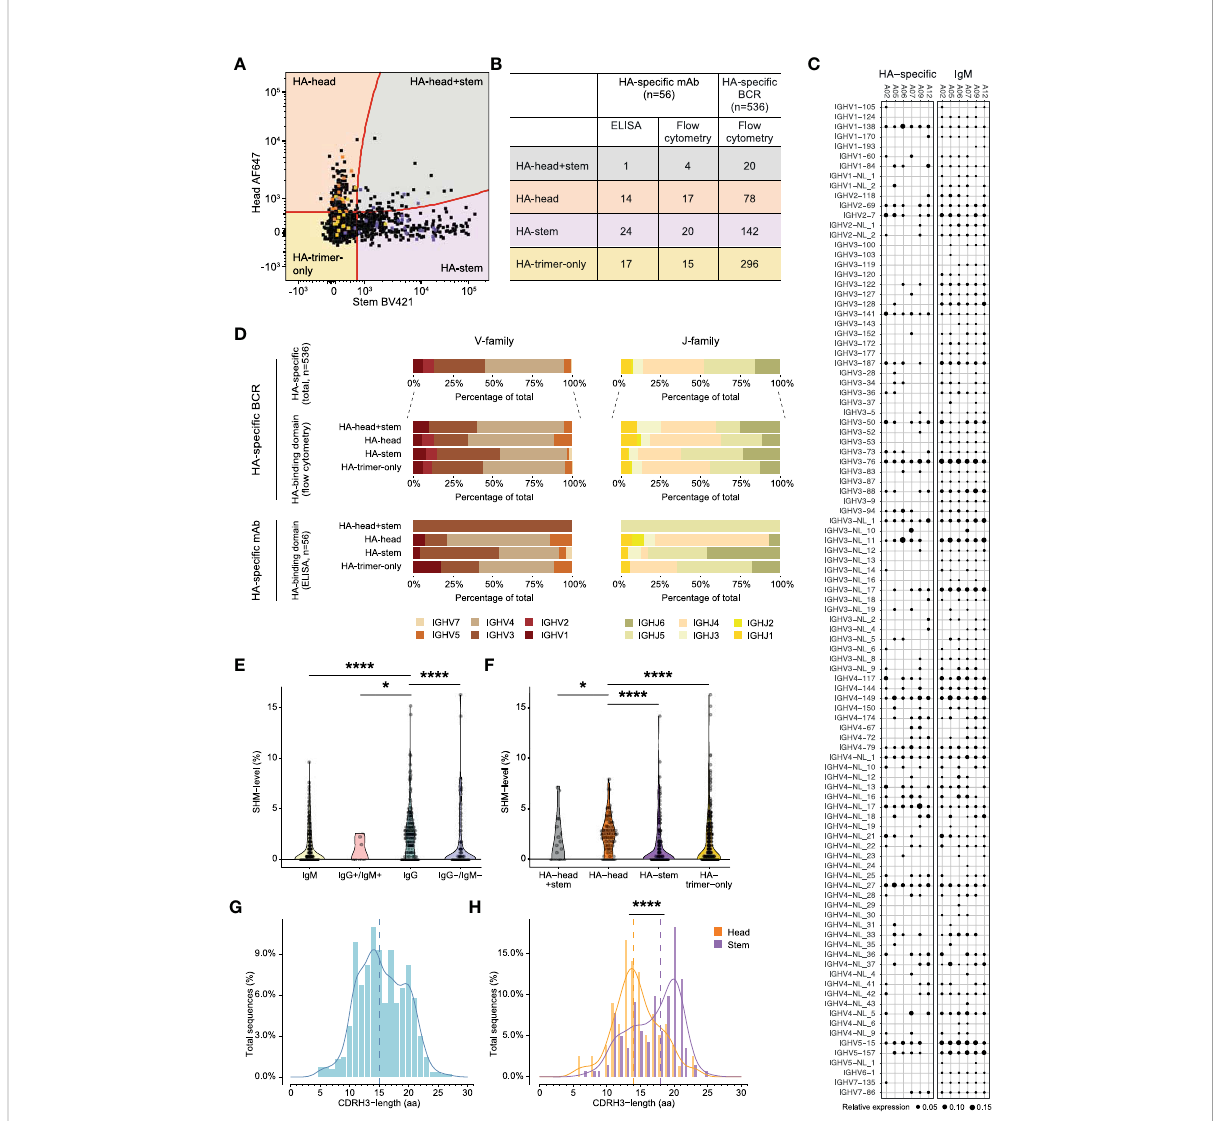
FIGURE 3 Characteristics of HA-speci fi c BCR repertoire and monoclonal antibodies (A) Overlay fl owcytometry plot of index-sorted HA-speci fi c B cells of six animals. Original B cells of isolated monoclonal antibodies are highlighted according to ELISA binding pattern, in orange HA-head, in yellow HA-trimer-only, in purple HA-stem, and in grey HA-head+stem. (B) Table presenting the binding domain of HA-speci fi c mAb in ELISA and fl ow cytometry and the binding domain HA-speci fi c BCRs in fl ow cytometry. (C) BCR repertoire of IgM germline and HA-speci fi c VH-gene usage. Size of the dots represent relative gene expression per animal. (D) Bar plots representing VH-gene (left) or JH-gene (right) family usage of HA- speci fi c total BCRs, HA-head+stem, HA-head, HA-stem, and HA-trimer-only speci fi c BCRs (upper panel) or isolated monoclonal antibodies (lower panel). (E) Violin plot showing VH-gene SHM-level of pre- (green) and post- infection HA-speci fi c BCRs. Post-infection BCRs are shown in IgM+, IgM+/IgG+, IgG+, and IgM-/IgG- isotypes. (F) Violin plot showing VH-gene SHM-level of HA-head+stem (grey), HA-head (orange), HA- stem (purple), and HA-trimer-only (blue) speci fi c BCRs. (G) Density histogram showing CDRH3-length in amino acids (aa) of total HA-speci fi c BCRs. Dotted line represents the median CDRH3-length. (H) Density histogram showing CDRH3-length distribution of HA-head (orange) and HA-stem (purple) BCRs. Dotted lines represent corresponding medians. Statistical differences between two groups were determined using the Mann-Whitney test (p values: *p < 0.05; ****p <